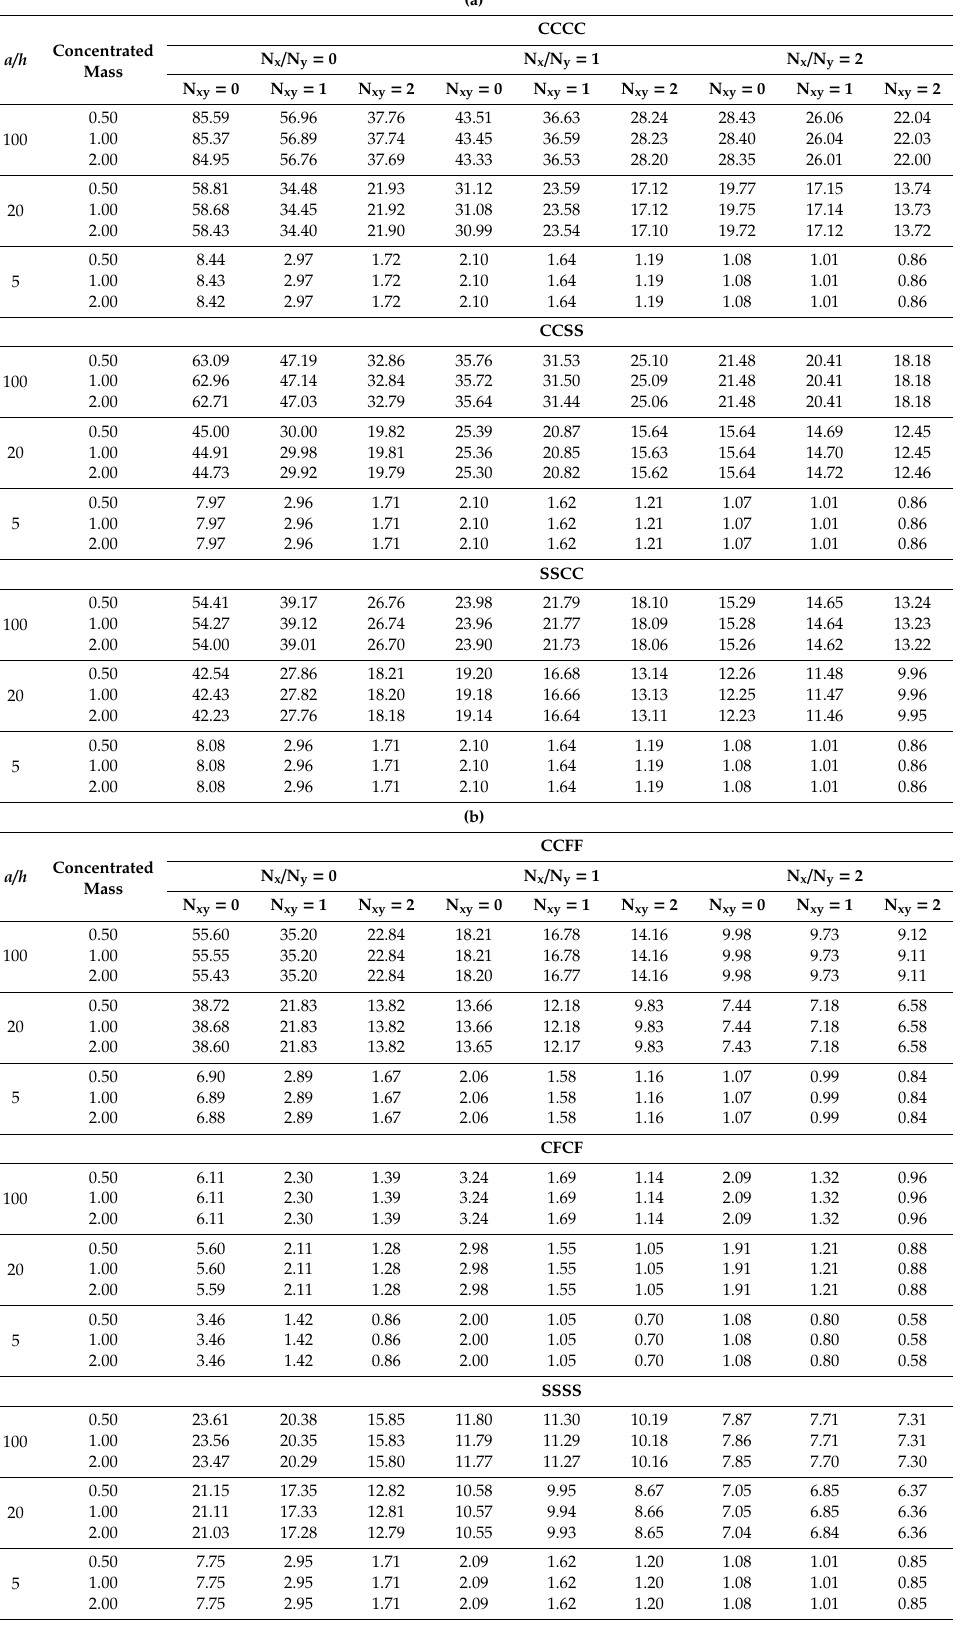
Table 7. ( a ) Non-dimensional buckling load λ = ( λ b 2 /E 2 h 3 ) for a bi-axial buckling of a composite plate having lamination scheme B and additional mass; ( b ) Non-dimensional buckling load λ = ( λ b 2 /E 2 h 3 ) for a bi-axial buckling of a composite plate having lamination scheme B and additional